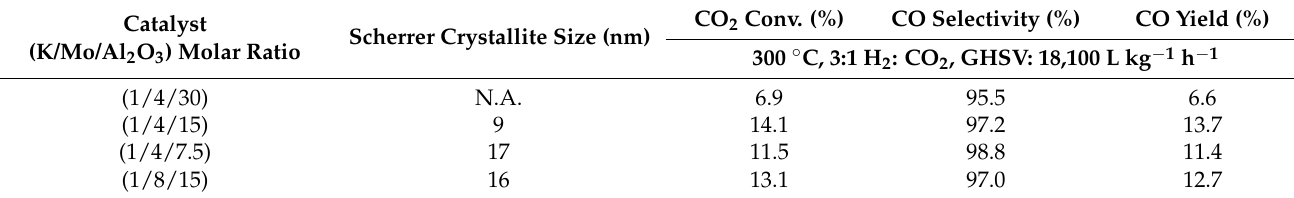
Table 3. Average crystallite size as calculated by Scherrer analysis, and RWGS activity for K-Mo 2 C@ γ - Al 2 O 3 catalysts of various loadings. All catalysts were tested under the following